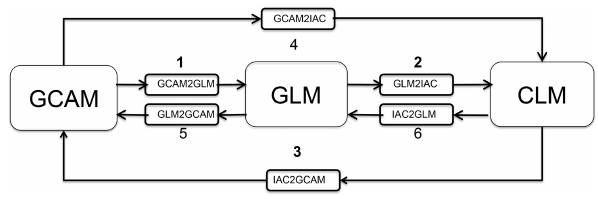
Figure 3. Schematic of the iESM interfaces among GCAM, GLM, and the CLM component of CESM. Several of these interfaces are unused in the initial implementation of the iESM.